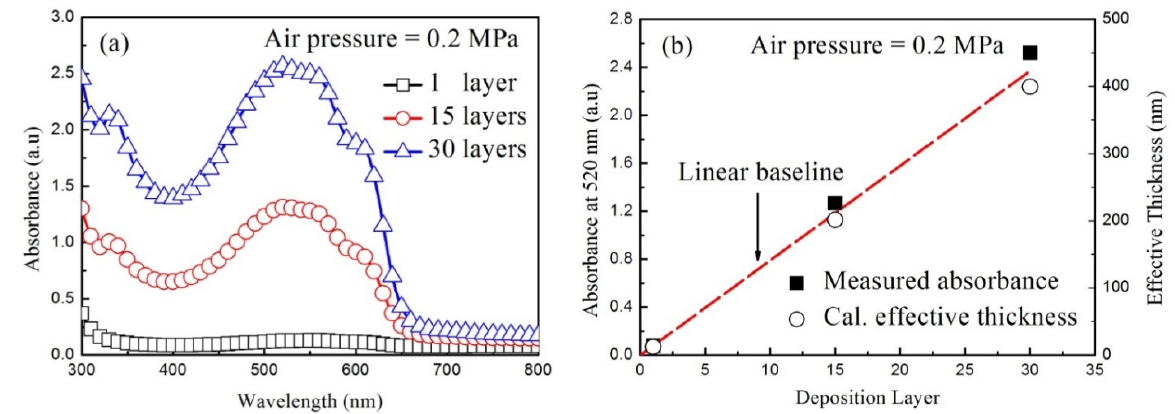
Figure 13. ( a ) UV-Visible absorption spectra of spray-on P3HT:PCBM films, where the measurement reference line is the surface of the spun-on PEDOT:PSS film, underneath the P3HT:PCBM film; ( b ) the measured absorbance and the calculated effective thickness for three deposition layers ( A = 0.0063 t , cf. Figure 10) for spray-on P3HT:PCBM films at 520 nm wavelength. In (b), the linear dashed baseline passes through the origin and